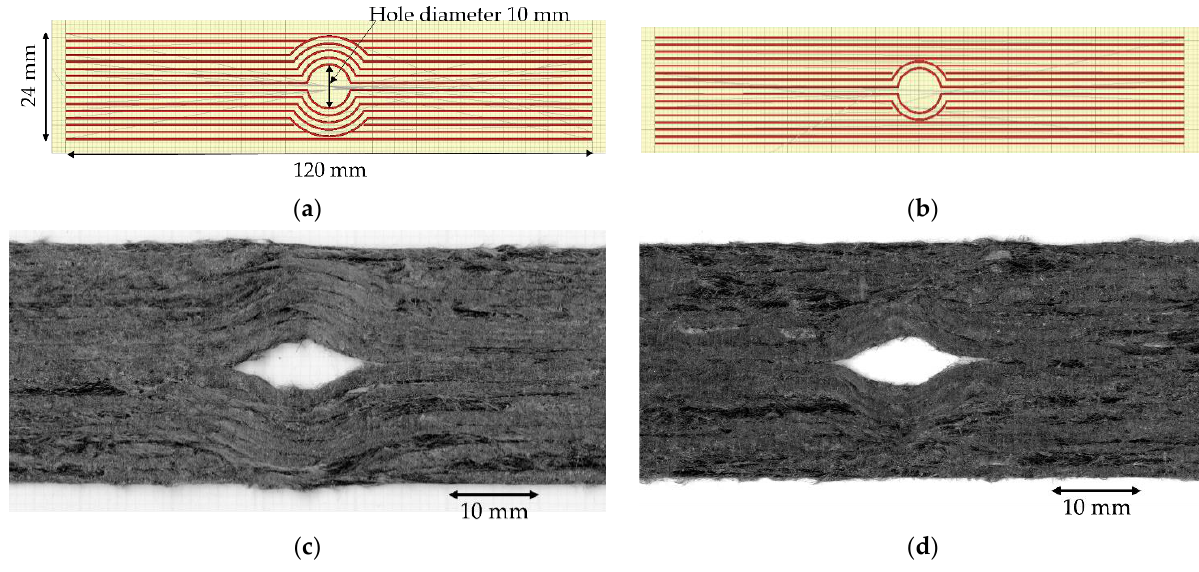
Figure 8. ( a , b ) Designed curvilinear 3D printing path for 10- and 4-curvature samples; ( c , d ) high magnification at the curvature hole of 10- and 4-curvature samples on the bottom side (sticking to the printing bed) [25].